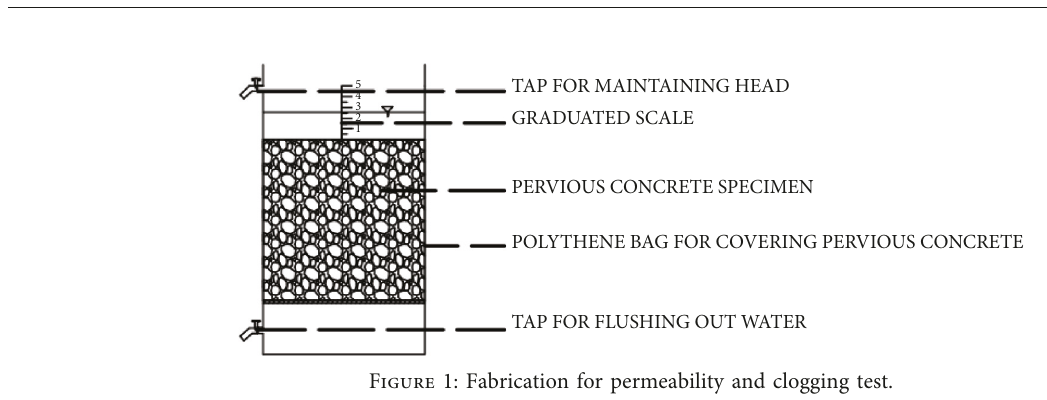
Figure 1: Fabrication for permeability and clogging test.